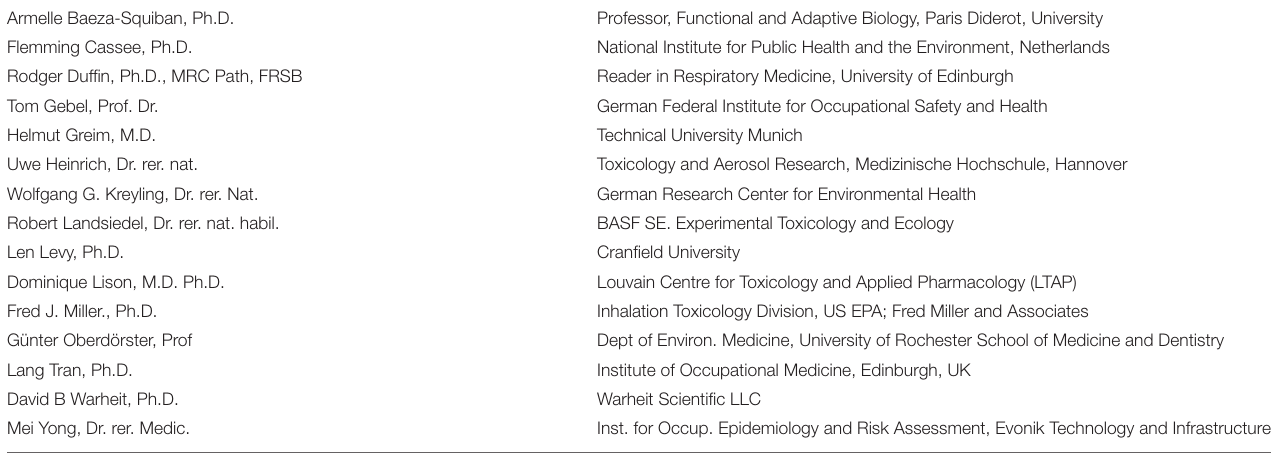
TABLE 2A | Edinburg Workshop Expert Panelists.